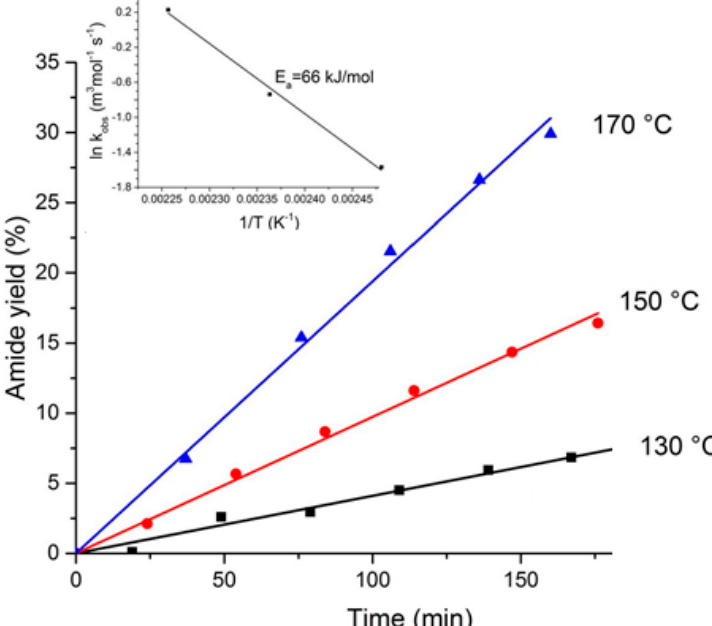
Figure 3. The amide yield as a function of time over T-50 in the batch reactor with a mixture of aniline (0.05 M) and 4-phenylbutyric acid (0.05 M) in p -xylene. The catalyst weight: 165 mg. Pressure: 6 bar.